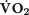
Dependence of total oxygen consumption (V˙O2), V˙O2 related to proton leak, V˙O2 related to ATP synthesis, Δp, NADH (% of total NAD) and phenomenological ATP/O2 ratio on relative activity of ATP usage (relative rate constant, kUT, or its activation in relation to rest, AUT) in skeletal muscle for proton leak activity (rate constant) elevated twice in relation to the ‘standard’ value.